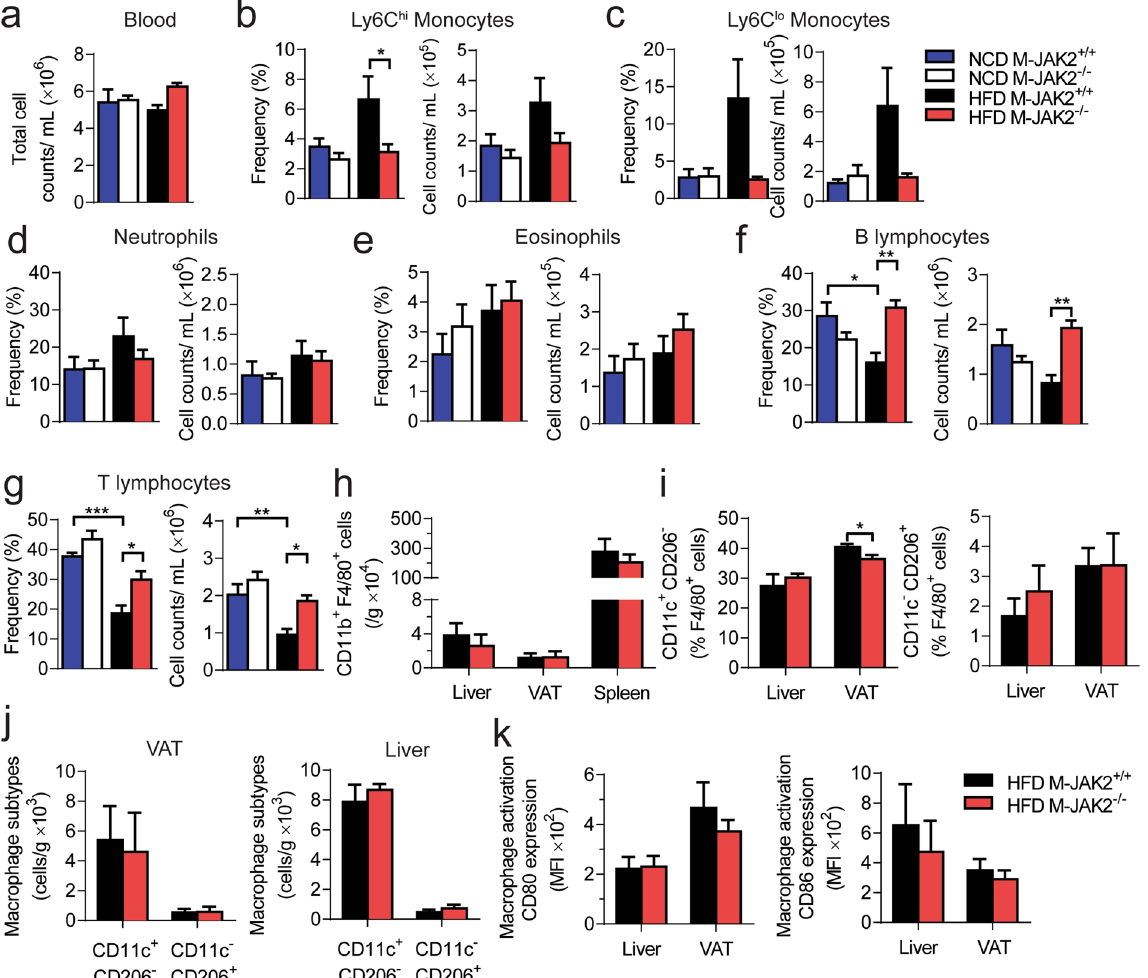
Figure 6. Characterization of circulating leukocytes, and macrophages in liver and VAT. ( a ) Total white blood cells, and ( b–g ) frequency and absolute number of ( b ) Ly6C high (Ly6C hi ) monocytes, ( c ) Ly6C low (Ly6C lo ) monocytes, ( d ) neutrophils, ( e ) eosinophils, ( f ) B lymphocytes, and ( g ) T lymphocytes in M-JAK2 + / + and M-JAK2 − / − mice fed a NCD (n = 5–7) or a HFD (n = 6–7). ( h ) Absolute numbers of CD45 + CD11b + F4/80 + macrophages in liver, visceral adipose tissue (VAT) and spleen, ( i ) frequency and ( j ) absolute numbers of CD11c + CD206 − and CD11c − CD206 + macrophages in VAT and liver, and ( k ) expression of the macrophage activation markers CD80 and CD86 in the VAT and liver of M-JAK2 + / + and M-JAK2 − / − mice fed HFD (n = 8–9 mice per group for VAT and n = 5–6 per group for spleen and liver, two independent experiments). Mean fluorescent intensity (MFI). All results are mean ± SEM; * p < 0.05, ** p < 0.01, *** p <